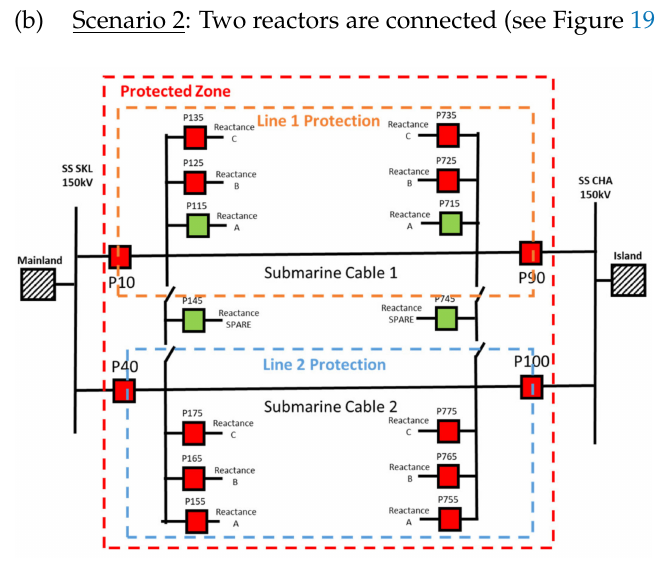
Figure 19. Reactive compensation: two reactors